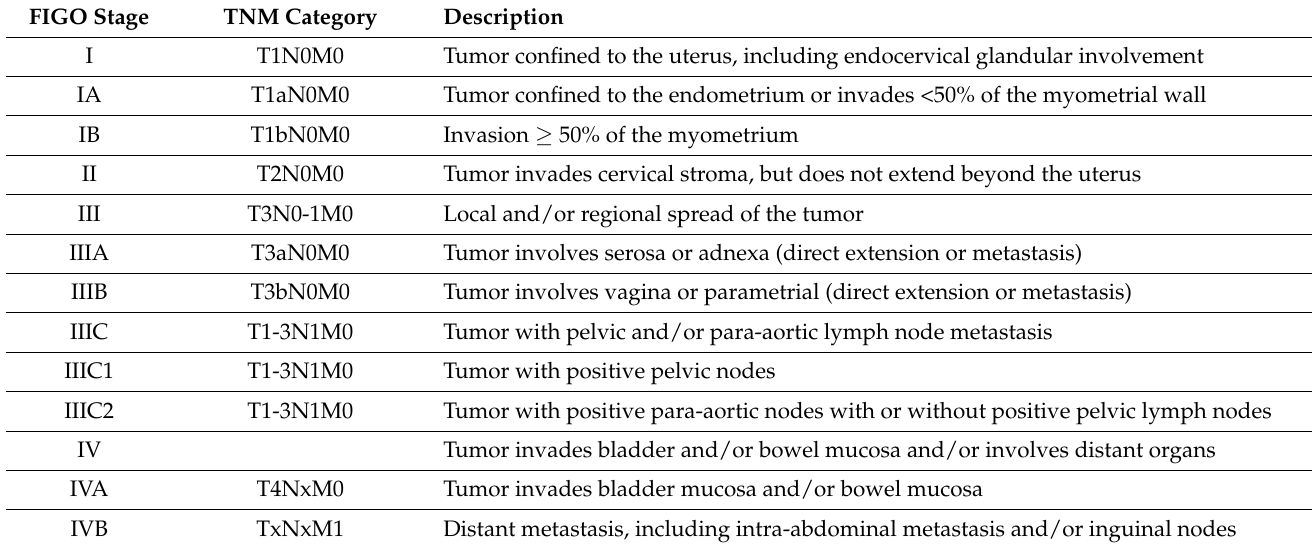
Table 3. FIGO staging for endometrial cancers (Koskas et al., 2021 [22]). FIGO, International Federa- tion of Gynecology and Obstetrics grading; M, metastasis; N, lymph nodes; T, tumor; x, any number. FIGO Stage TNM Category